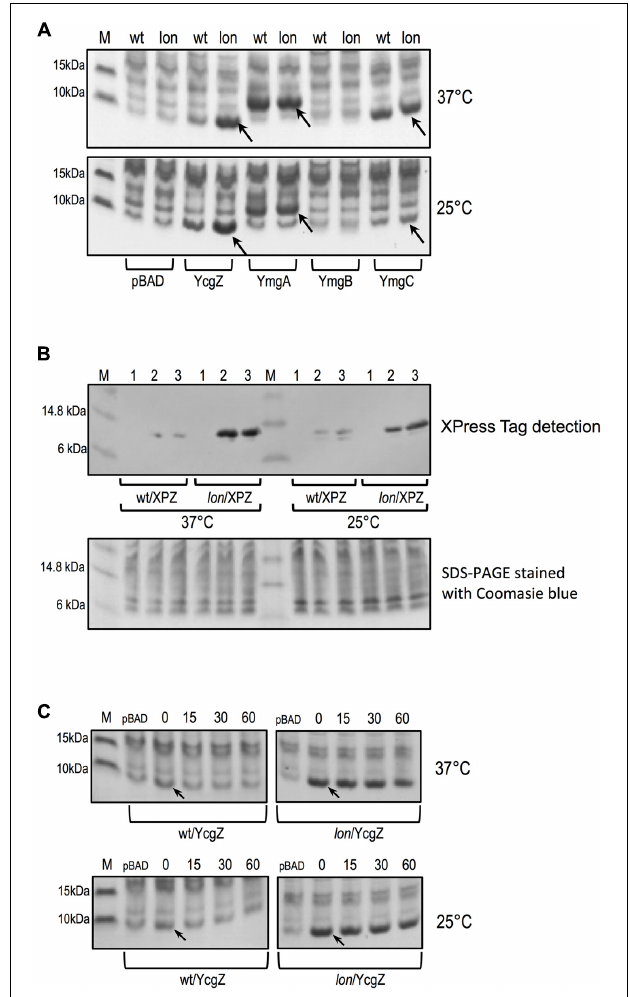
FIGURE 6 | Protein levels of YcgZ, YmgA, YmgB, and YmgC in E. coli wild type (BW25113) and lon mutant (JW0419-1). (A) Steady-state level of native YcgZ, YmgA, YmgB, and YmgC expressed with plasmids pBAD (empty plasmid), pDVBZ (YcgZ), pDVBA (YmgA), pDVBB (YmgB), and pDVBC (YmgC), respectively and 0.05% of L -arabinose. (B) Steady-state level of XPress-tagged YcgZ expressed with pDVBZ-XP plasmid and detected by immunoblotting. 1, no L -arabinose; 2, 0.005% L -arabinose; 3, 0.05% L -arabinose. (C) Stability of native YcgZ expressed with plasmid pDVBZ. The numbers indicate the time in minutes after addition of 150 µ g ml - 1 chloramphenicol. For all experiments, the target gene was expressed from an araBAD promoter using pBAD derivative plasmids. The strains carrying plasmids were grown to an optical density of 1 in the presence of L -arabinose at 37 and 25 ◦ C, respectively. Whole cell extracts were then prepared and analyzed by SDS-PAGE and the gels were stained using Coomassie (A,C) . The arrow indicates the band corresponding to the expressed protein. Each lane contains 8 µ g of proteins. M, Benchmark Protein Ladder.